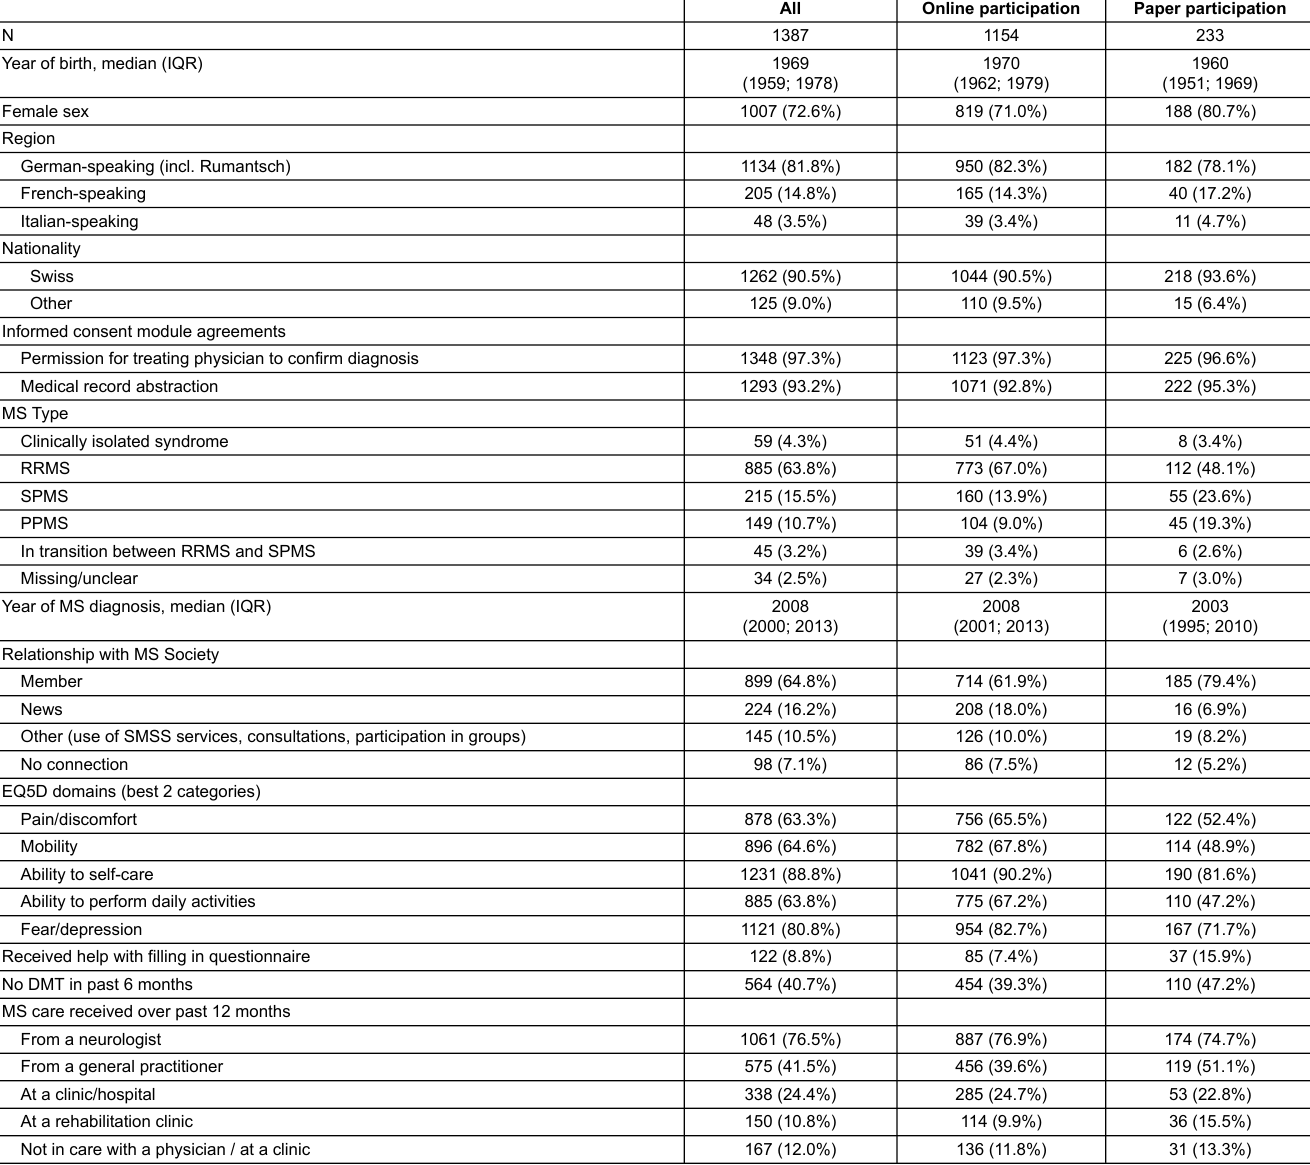
Table 2: Characteristics of study population enrolled in the first 18 months and who completed the layer 2 questionnaire.